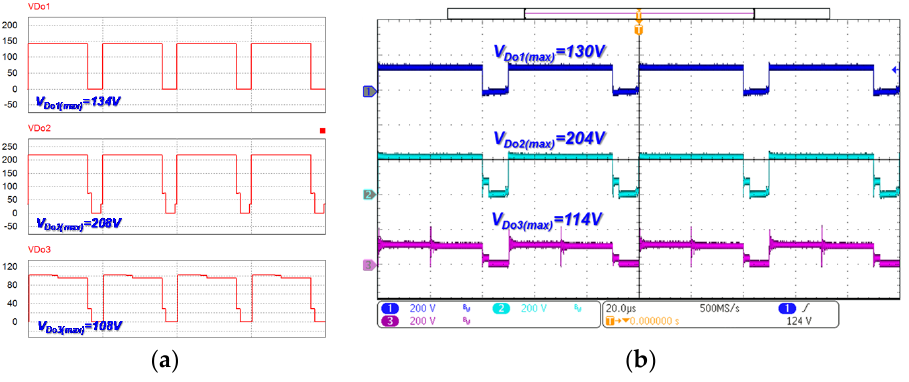
Figure 9. Diode voltage waveforms in the battery discharging mode: ( a ) by simulation; and ( b ) by measurement.